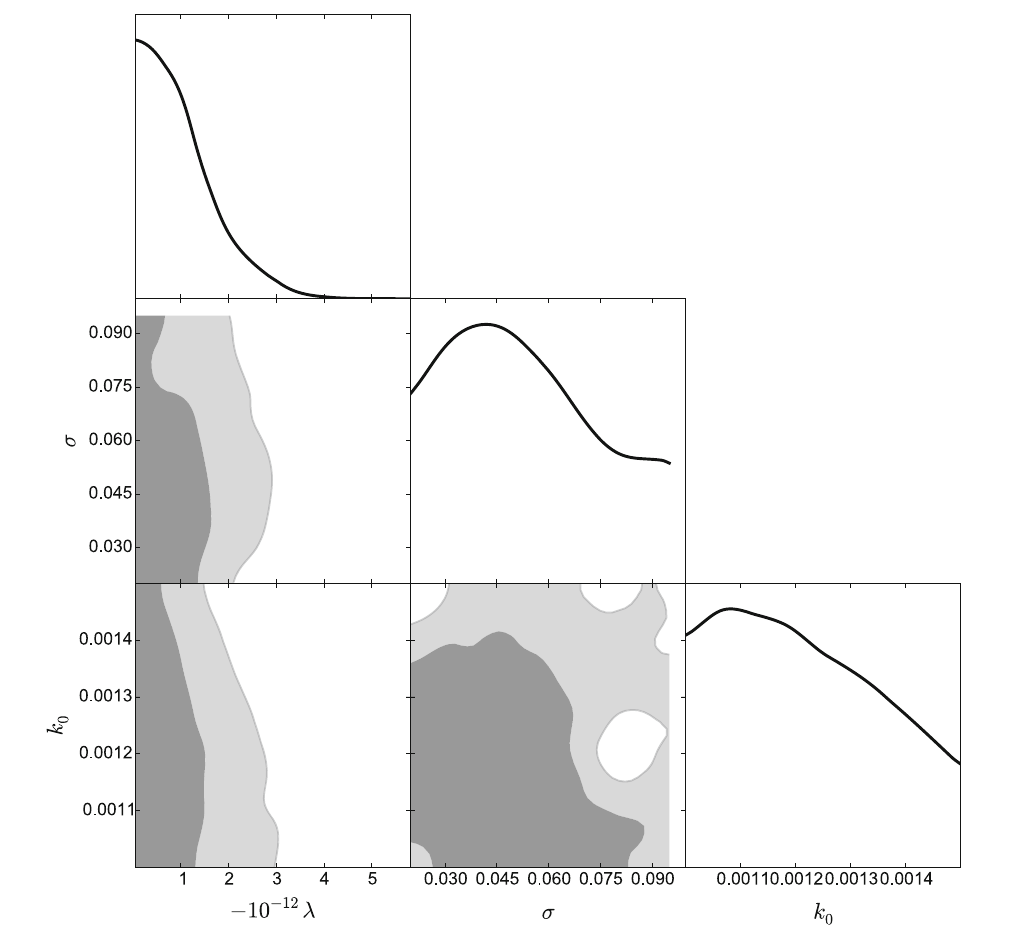
Fig. 6 The results of the data fitting analysis for the parameters λ , σ and k 0 are shown for the model with local features